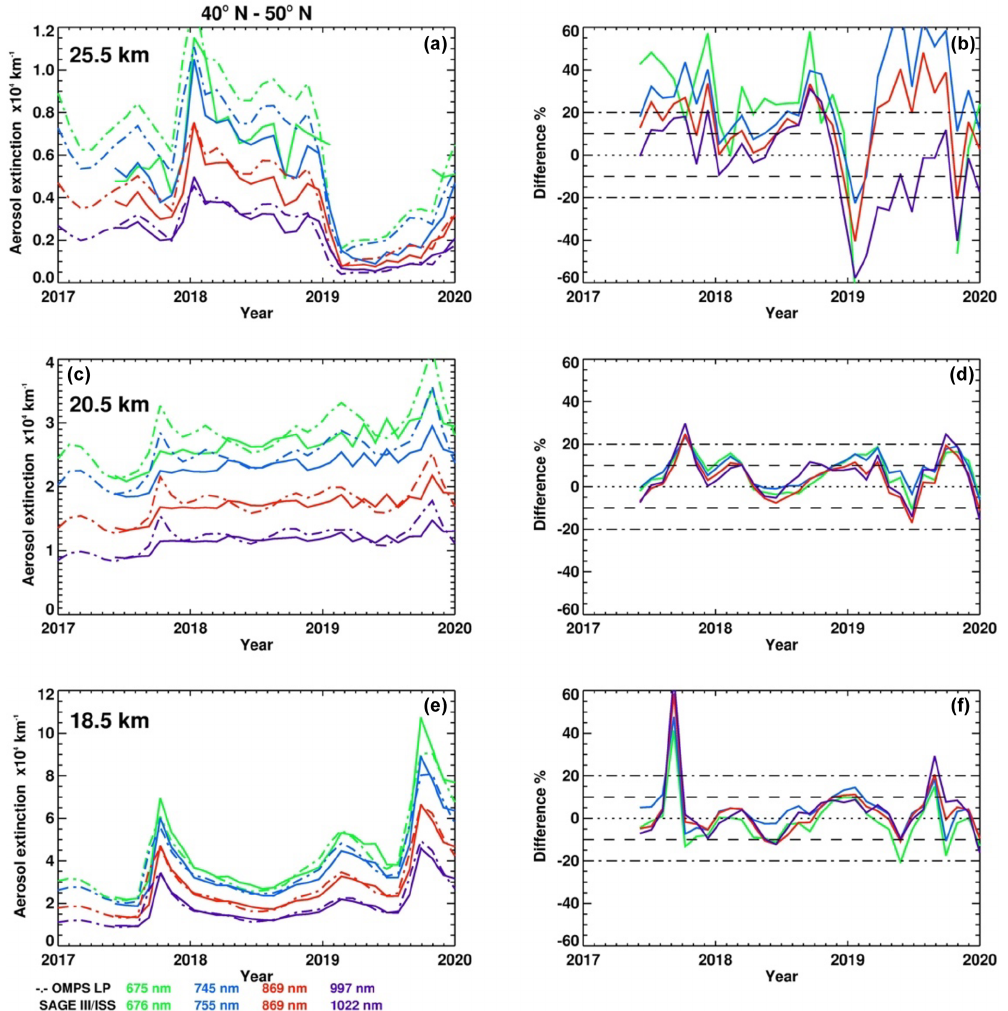
Figure 11. Same as Fig. 9 but for latitude zone 40–50 ◦